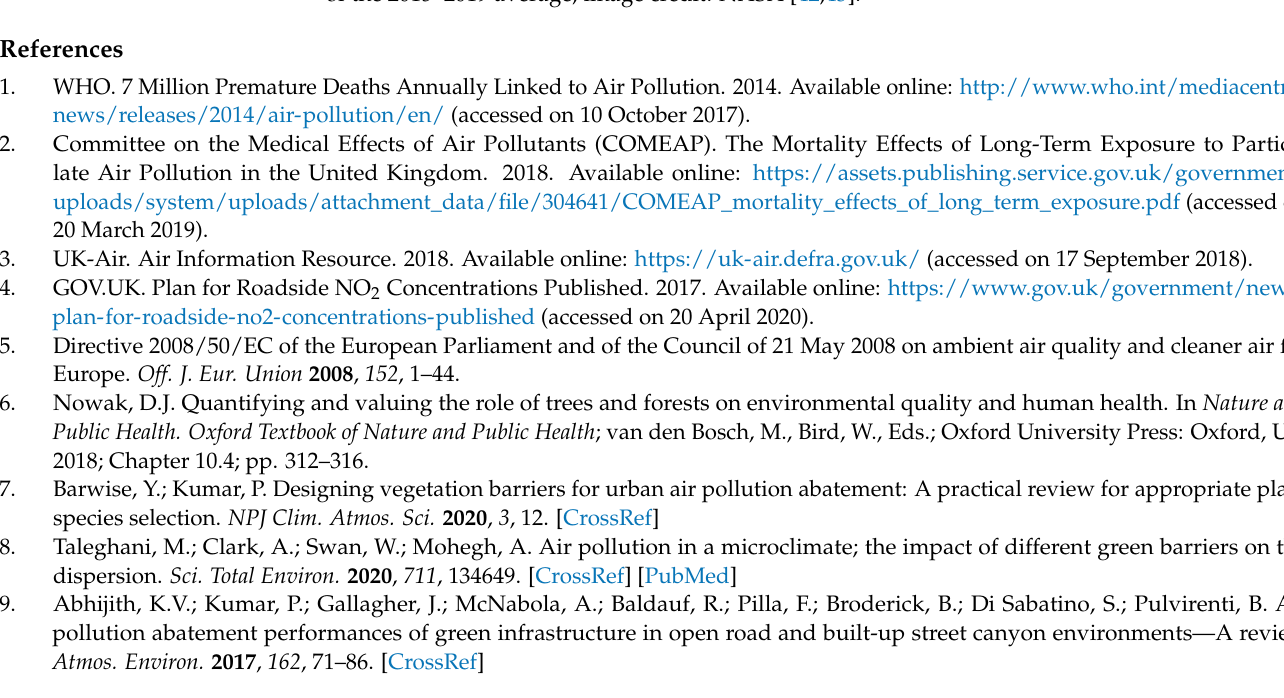
Figure A1. Comparison of NO 2 concentration between 1 April 2020 and the same day in the baseline of the 2015–2019 average, image credit: NASA [42,43].